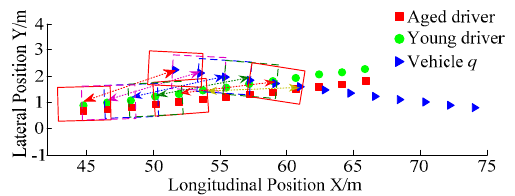
Figure 20. Trajectories of the vehicles driven by different drivers.